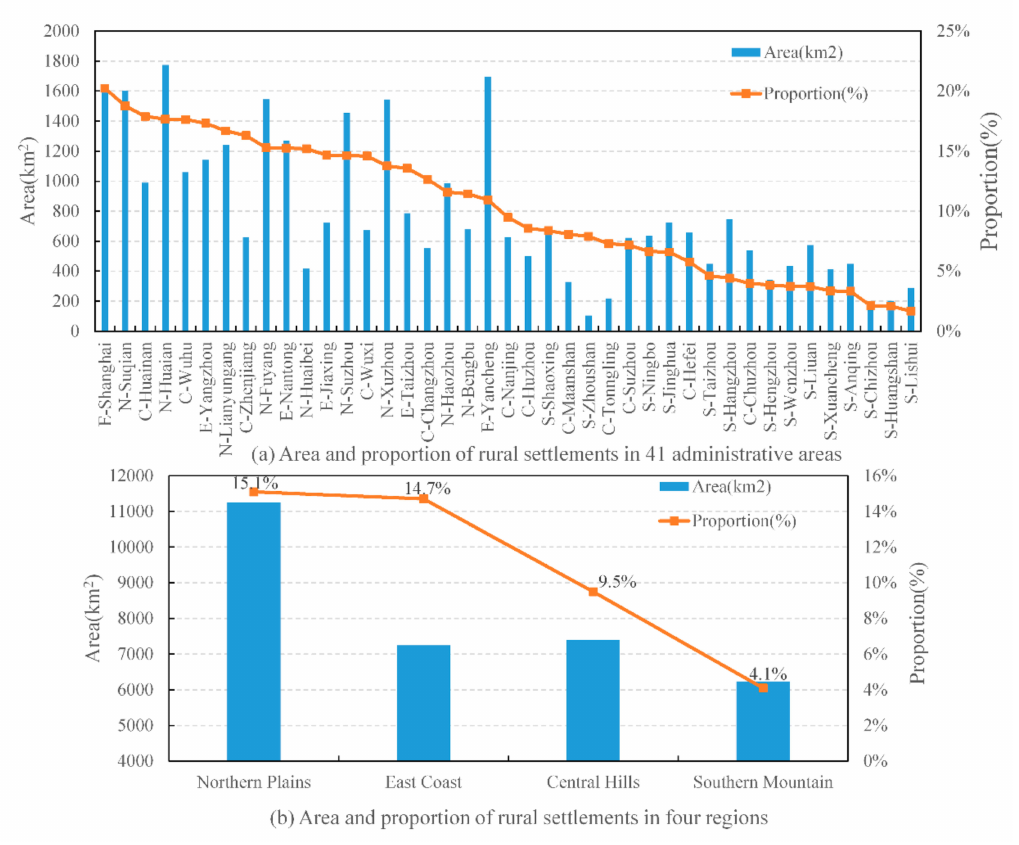
Figure 8. Area and proportion of rural settlement at di ff erent levels. ( a ) Municipal district level, ( b ) Region